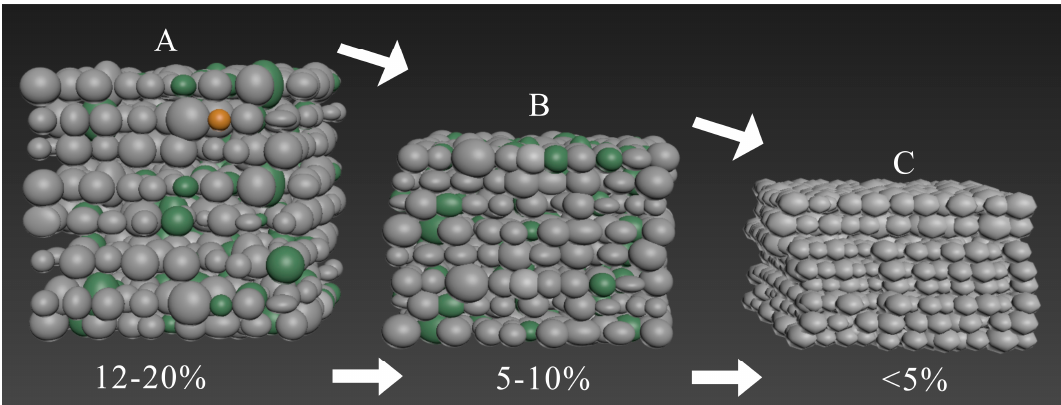
Figure 7. 3D model of evaluation of quartz sandstone reservoir. ( A ) quartz grains before the diagenesis corresponding to Figure 6A; ( B ) quartz grow to the hexagonal dipyramid grain corresponding to Figure 6C; ( C ) the dipyramid grain suffered both the cementation and compaction corresponding to Figure 6D.